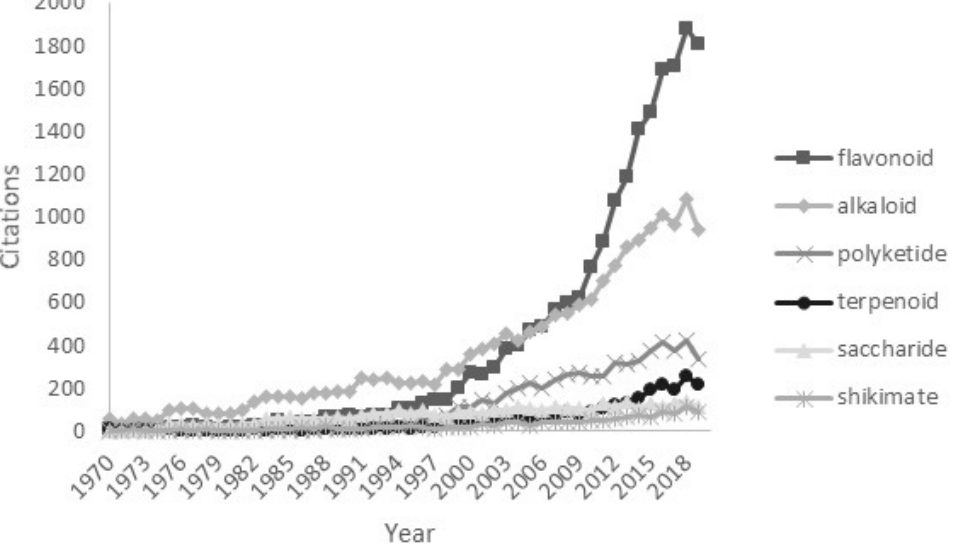
Figure 1. The number of research articles containing the names of the main groups / subgroups of natural products in the title / abstract from 1967 to 2019. Data obtained from PubMed on 22 September 2019.